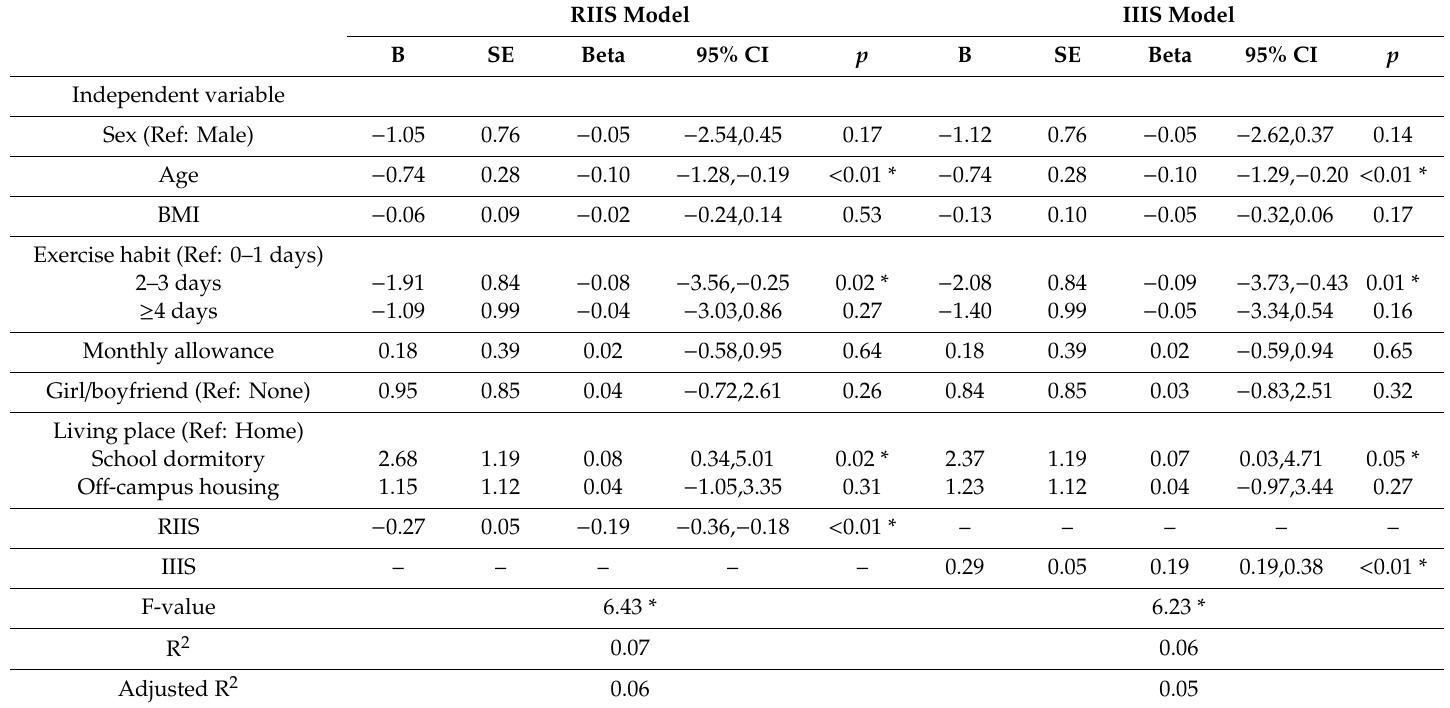
Table 2. Multiple regression analysis on factors a ff ecting psychological distress (i.e., Depression, Anxiety, Stress Scale; DASS-21) by interpersonal interaction (real and